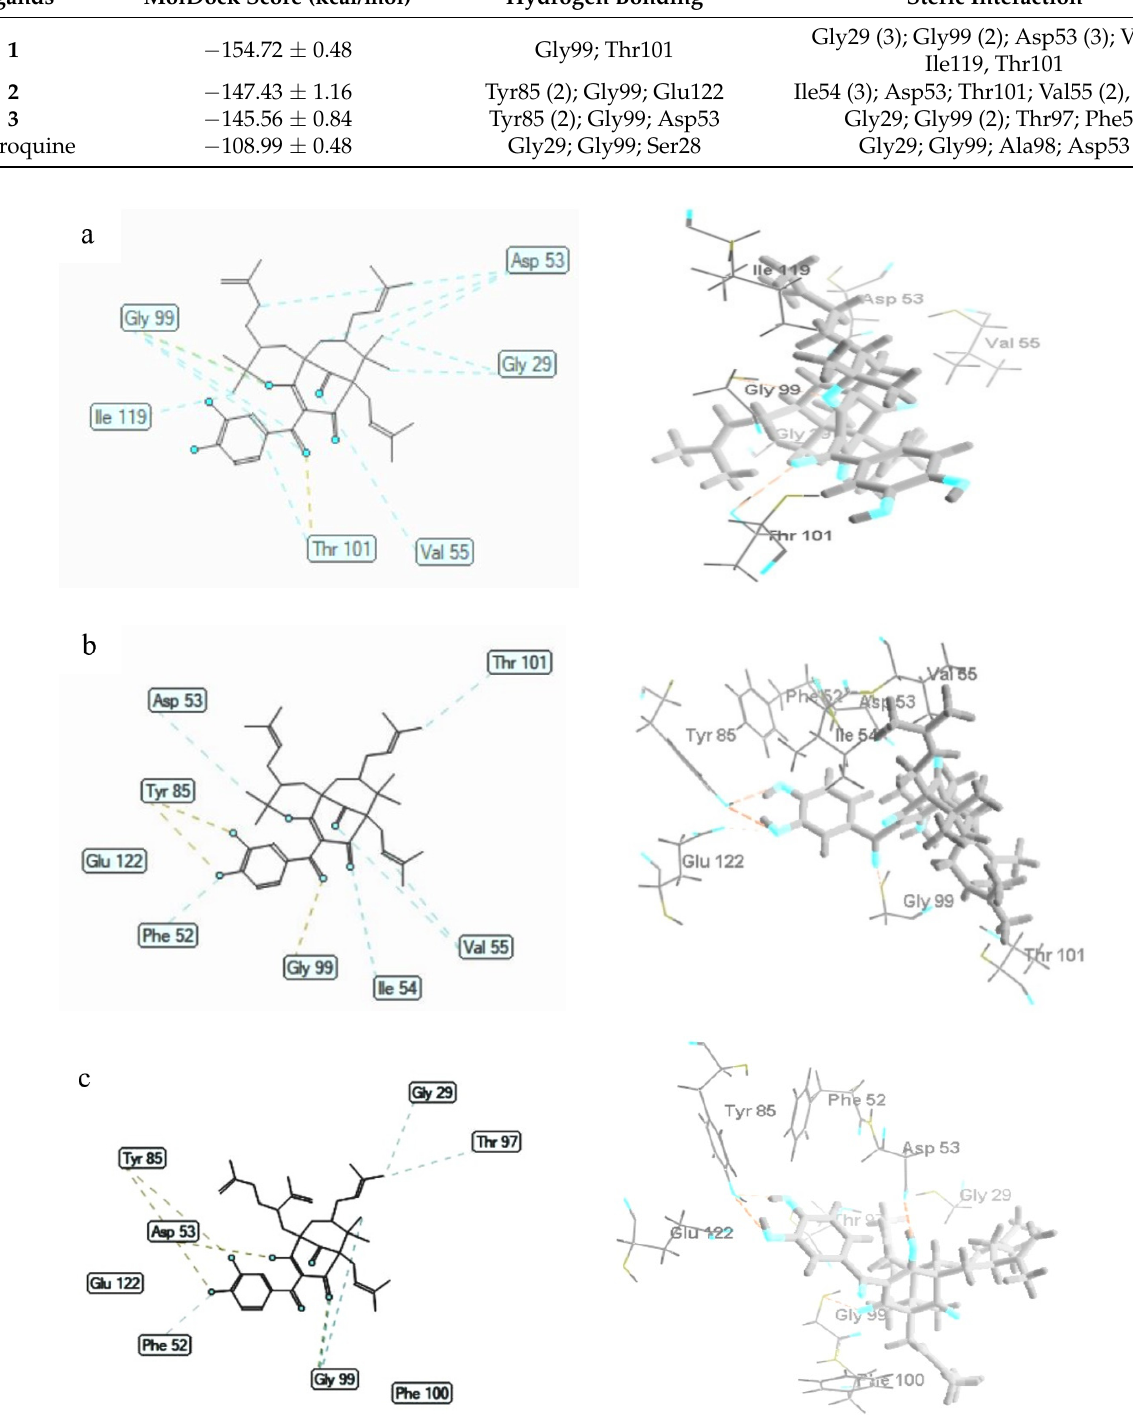
Table 7. MolDock score and interacting residues of 1 , 2 , and 3 to P. falciparum lactate dehydrogenase enzyme (1CET).